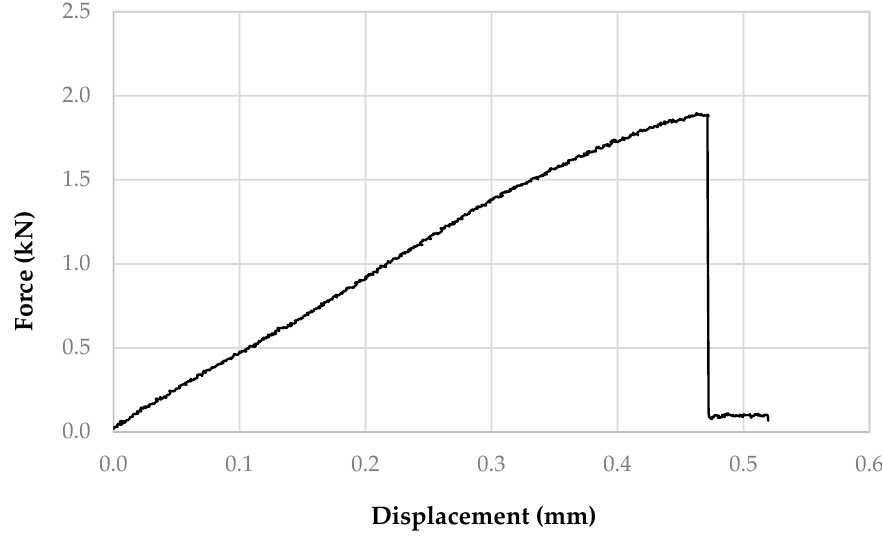
Figure 7. Typical force-displacement graph of a lap joint test (TSMA01).